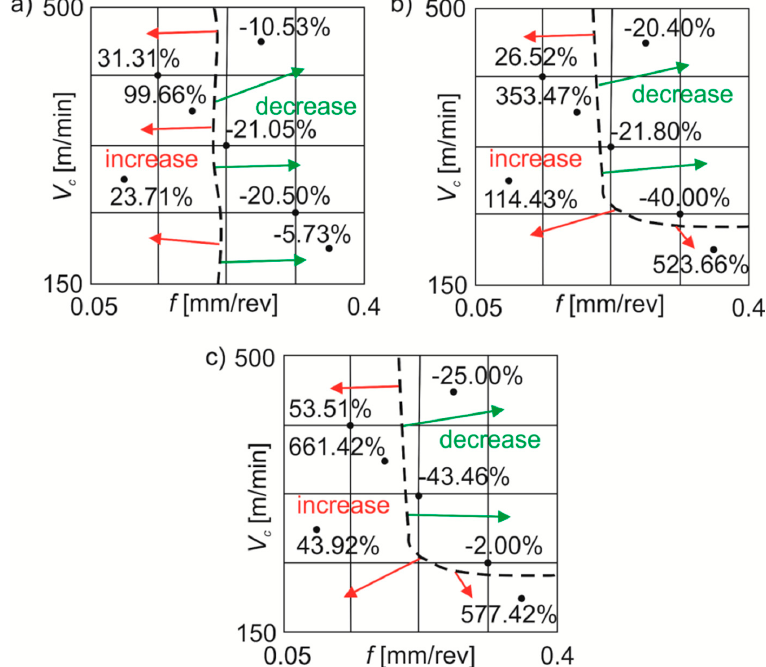
Figure 9. Average percentage changes in the Sq roughness parameter under: ( a ) wet turning; ( b ) MQL; ( c ) MQL+EP conditions in comparison with dry turning.